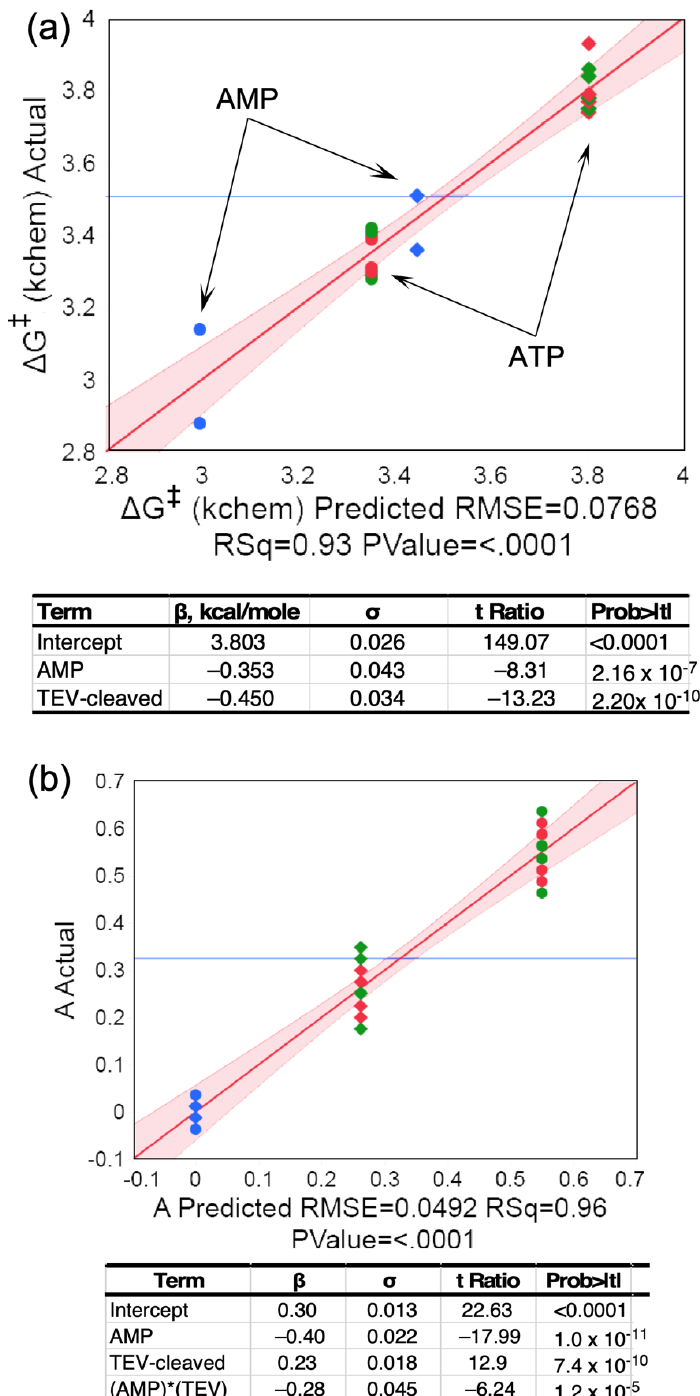
Figure 3. Multiple regression analyses of the dependence of ΔG ‡ k chem and burst size on TEV cleavage and nucleotide. ( a ). Dependence of ΔG ‡ k chem on nucleotide and TEC cleavage. The smaller activation free energy for AMP production by both catalysts (arrows) implies that reaction occurs faster. ( b ). Analysis of dependence of burst size ‘A’ on nucleotide and TEV cleavage. Data drawn from AST experime nts in Table I and performed using both [α - 32 P] and [γ - 32 P] ATP. In both ( a , b ) circles rep- resent TEV cleaved, diamonds fusion protein, blue and green parameters calculated from AMP and ADP production, respectively, and red parameters calculated from ATP consumption. R 2 and over- all F-ratio p -values are included in the X axis labels. Tables include β coefficients with σ values, Student t -tests, and p values.